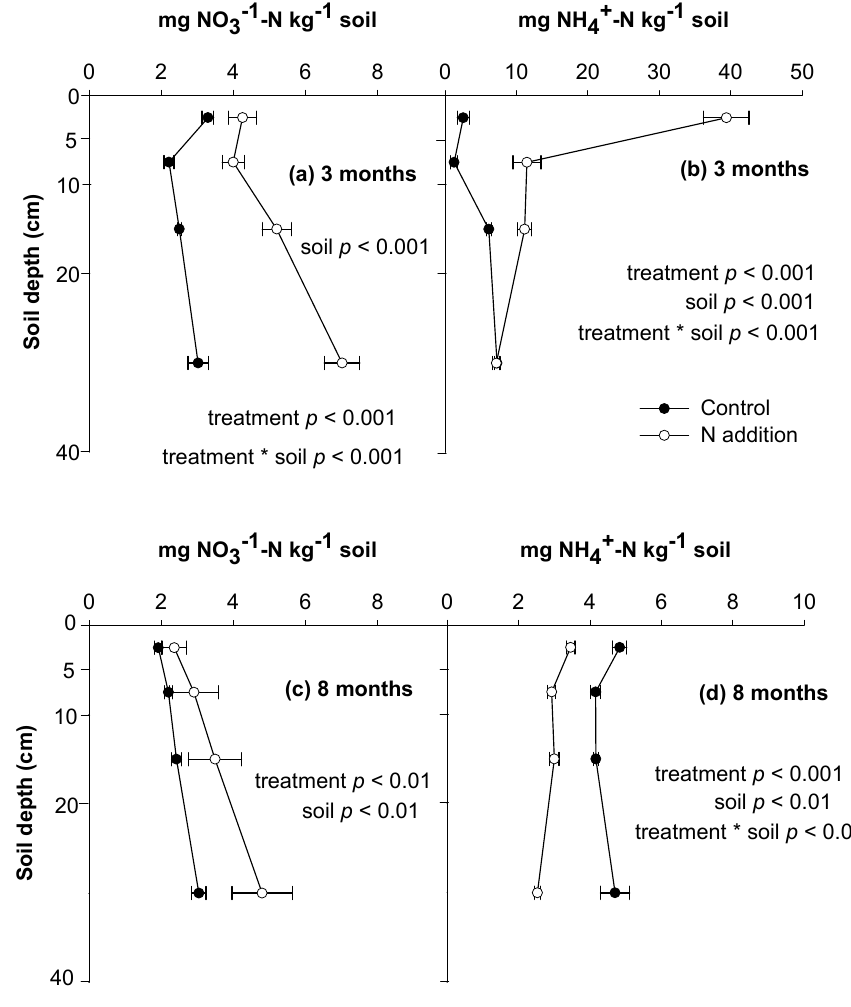
Figure1. ( a ) Concentration of soil total (indigenous + exogenous) NO 3 − (mean ± standard error (se); n = 8) three months after N addition. ( b ) Concentration of soil total (indigenous + exogenous) NH 4+ (mean ± se; n = 8) three months after N addition. ( c ) Concentration of soil total (indigenous + exogenous) NO 3 − (mean ± se; n = 5) eight months after N addition; ( d ) Concentration of soil total (indigenous + exogenous) NH 4+ (mean ± se; n = 5) eight months after N addition. Data are graphed at the mid-point of our soil sampling